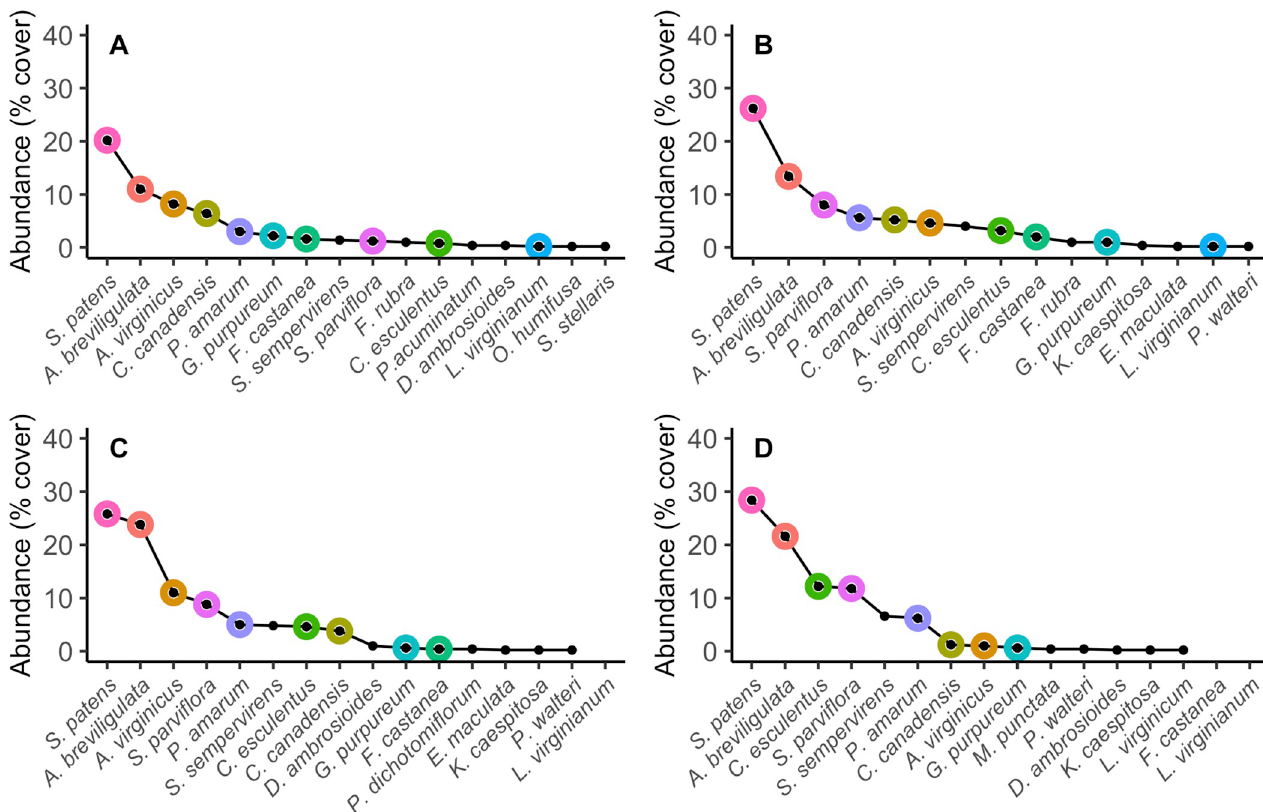
Fig 4. Rank abundance curves of species across nutrient enrichment treatments. Rank abundance curves (RACs) for all species in each treatment group. A, B) RACs for species in control and phosphorus plots, respectively. C, D) RACs for species in nitrogen and nitrogen + phosphorus plots, respectively. Species that were found to significantly correlate with the spread on plots in the NMDS analysis (Fig 2) are highlighted with a colored